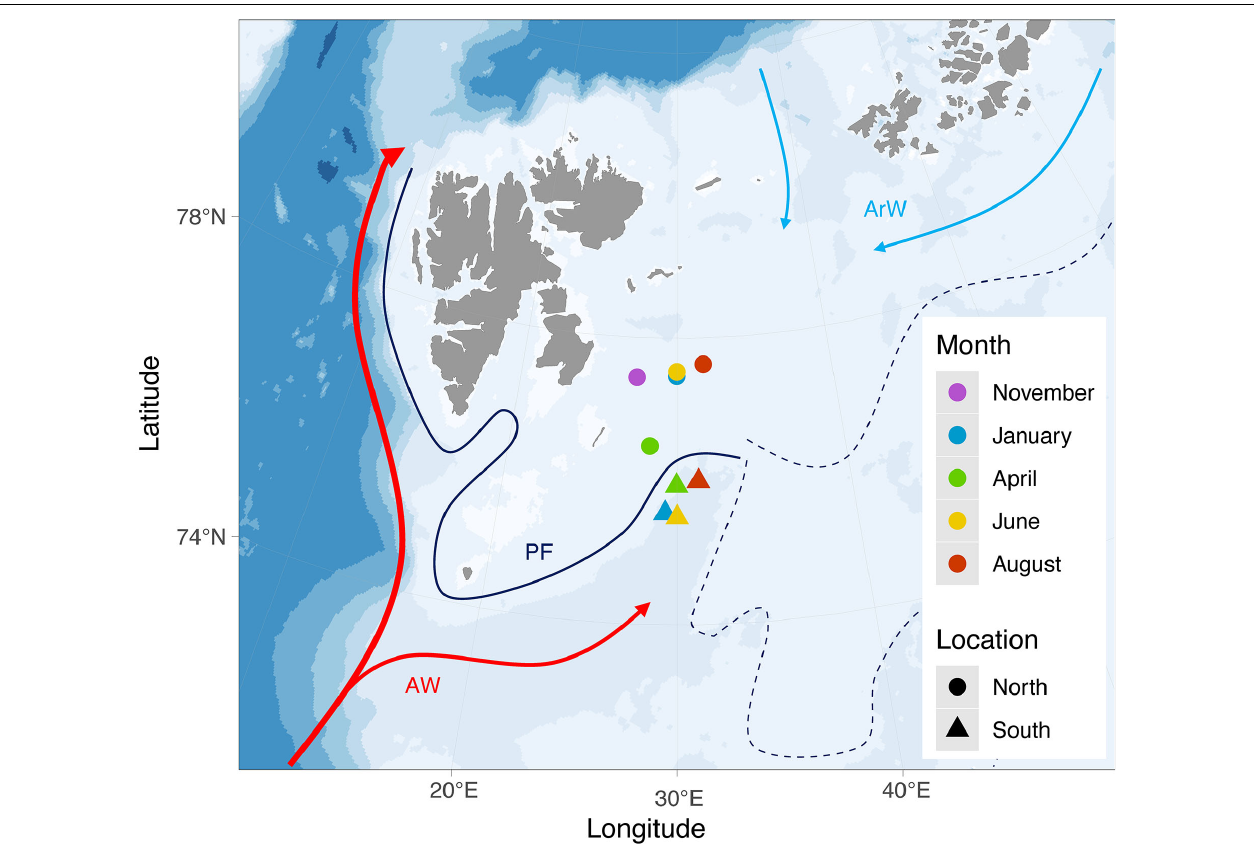
FIGURE 1 | Study area with sampling locations. Map was produced using package ggOceanMaps in R (Vihtakari, 2020). Arrows show Atlantic (AW, red) and Arctic (ArW, blue) water currents while the whole dark line represents the approximate location of the oceanographic Polar Front (PF) where it is stable, west of 32 ◦ E, and dashed lines represent the more variable southern and northern fronts to the east (based on Loeng, 1991; Oziel et al.,